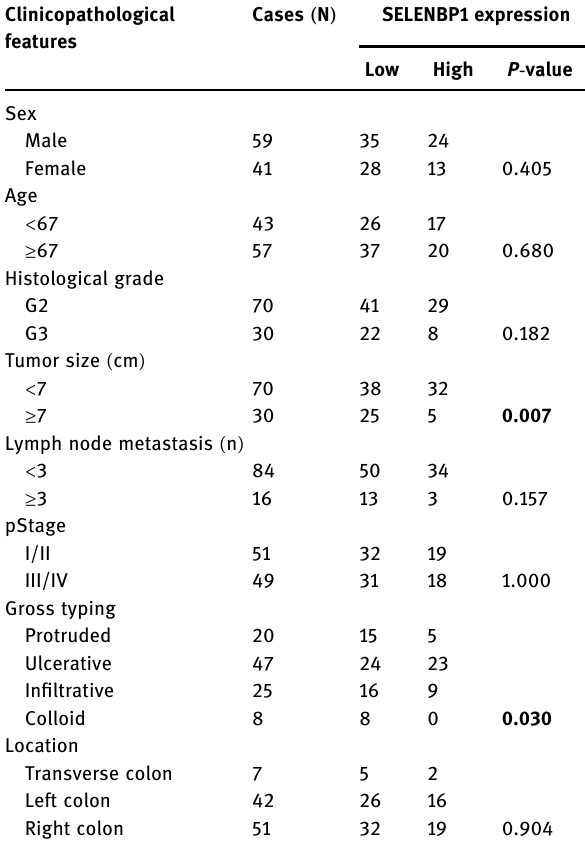
Table 1: Clinical signi fi cance of SELENBP1 expression in colon cancers ( n = 100